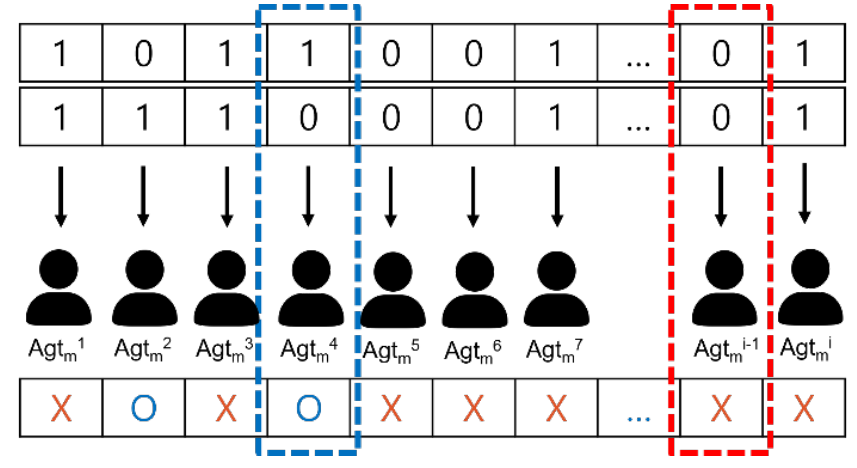
Figure 4. Training Strategy.